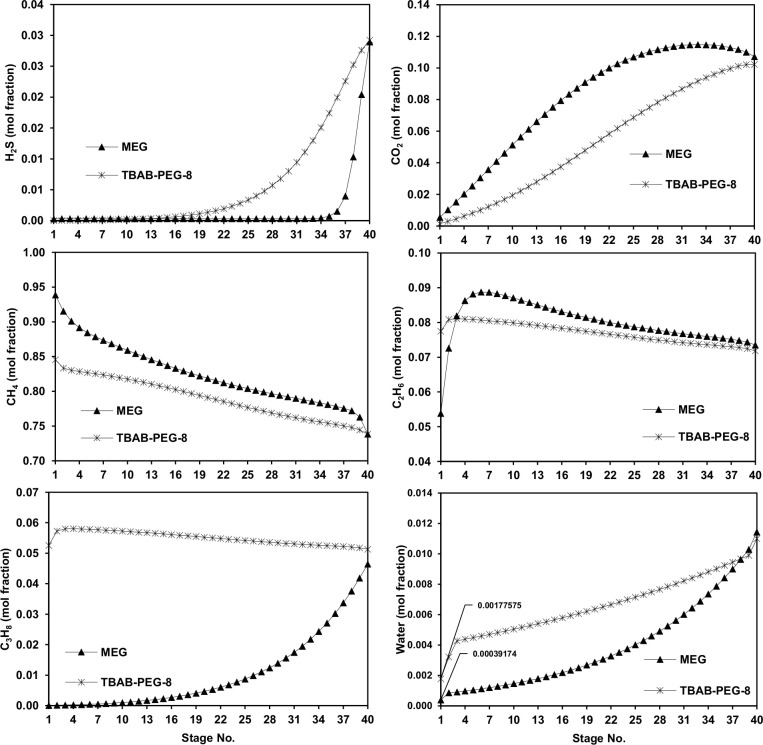
Vapor composition profiles for H2S, CO2, CH4, C2H6, C3H8 and water as function of the theoretical number of trays in the absorber.